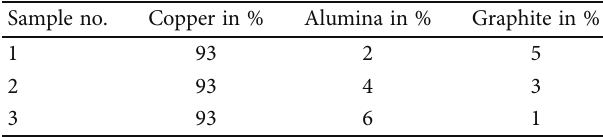
Table 3: Constitutions of copper hybrid